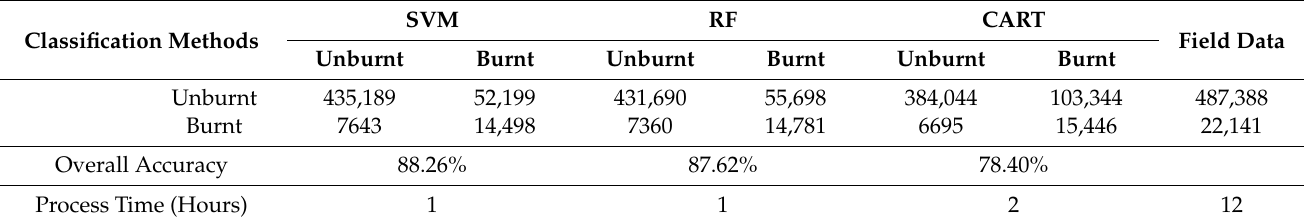
Table 2. Overall accuracy (OA) and processing time of the classifiers, compared to the field data.